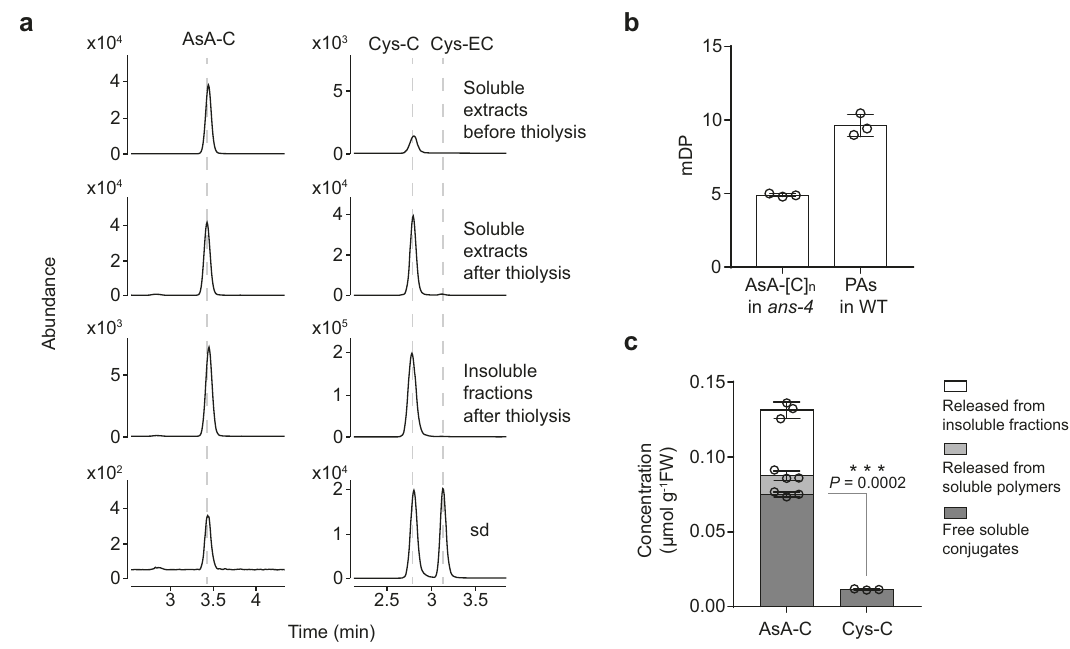
Fig. 6 Thiolysis analysis of the soluble extracts and the insoluble fractions of 7 DAP siliques of ans-4 mutant in the presence of excess Cys. a UHPLC- QqQ analysis of AsA-C with MRM transition of m/z (463.1 → 175.0), and Cys-C and Cys-EC with MRM transition of m/z (408.1 → 125.0) in the soluble extracts before and after thiolysis and the insoluble fractions after thiolysis in the presence excess Cys. sd: standard. Note that the ion abundances are not directly comparable among different types of samples, as different dilution factors were applied to each sample to prevent the over-saturation of ion abundance in the QqQ detector. b The mDP of soluble AsA-[C] n in the ans-4 mutant and soluble PA in WT. Data are shown as the mean ± SD (for n = 3 biologically independent samples). c The concentration of AsA-C from different fractions and free Cys-C in ans-4 mutant sample. FW: fresh weight. Data are shown as the mean ± SD (for n = 3 biologically independent samples; *** P < 0.001, two-tailed unpaired Student ’ s t tests). Source data of Fig. 6b and c are provided as a Source Data fi